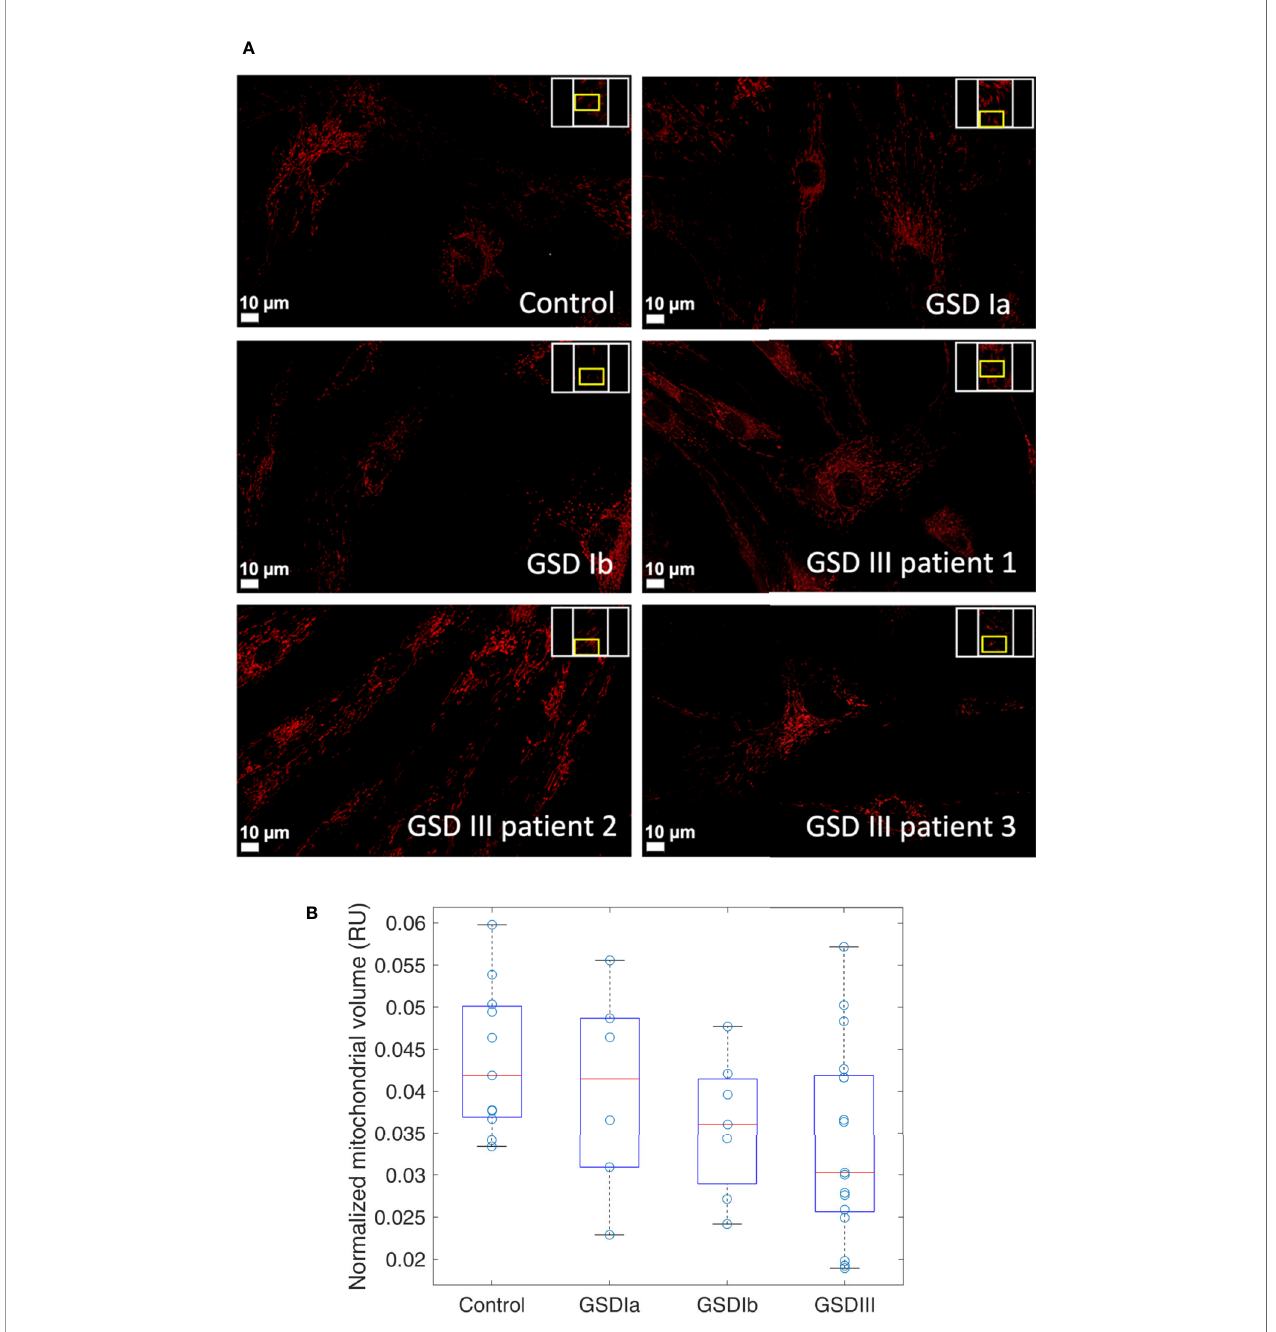
FIGURE 2 | Visualization and quanti fi cation of mitochondria in human skin fi broblasts from healthy controls and from GSD patients. Panel (A) Spinning-disk live imaging of mitochondria (red, MitoViewTM 650, Biotium). Scale bars show 10 µm. Panel (B) Boxplots of relative mitochondrial volume measurements in healthy controls and in patients with GSD Ia, GSD Ib and GSD III. Each data point represents a ratio of mitochondrial volume by the respective cellular surface. This ratio is herein expressed as relative units (RU). A minimum of three regions were examined per sample. In the boxplots, the red lines indicate the median and the box hinges describe the 1st and 3rd quartiles. The box whiskers represent the most extreme data value that is not larger (or smaller) than 1.5 times the interquartile range. Boxplots show a similar median in all the groups with less variability observed in the GSD Ib group. Statistical analysis by Kruskal-Wallis retrieved no signi fi cant differences between the controls and GSD subtypes ( a =